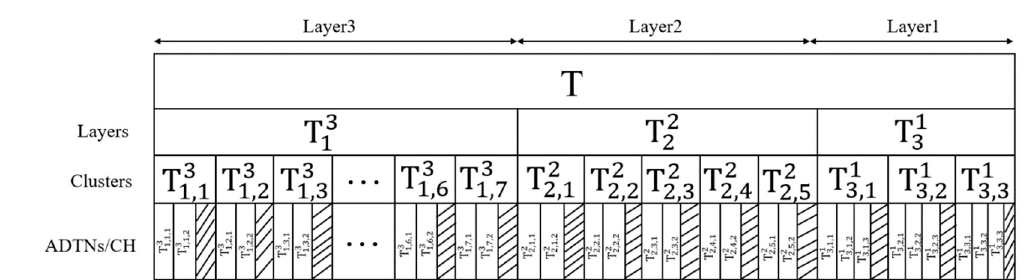
Figure 5. Example of slot scheduling for a three-layer network.